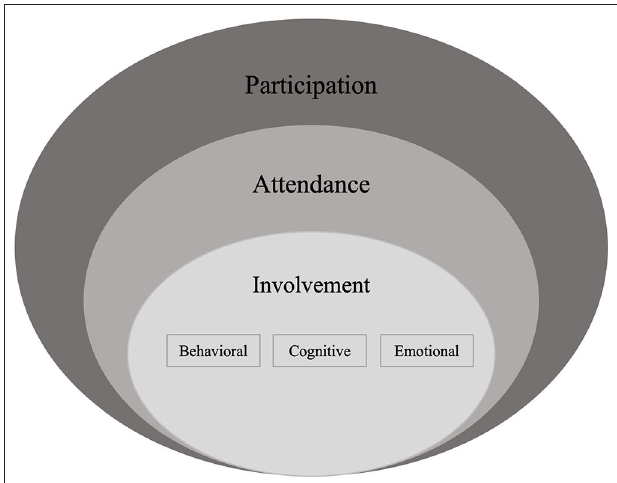
FIGURE 2 | Conceptualization of participation based on contemporary frameworks of participation. Informed by the family of Participation-Related Constructs (fPRC) ( 2, 3) as paired with research on the conceptualization of involvement (